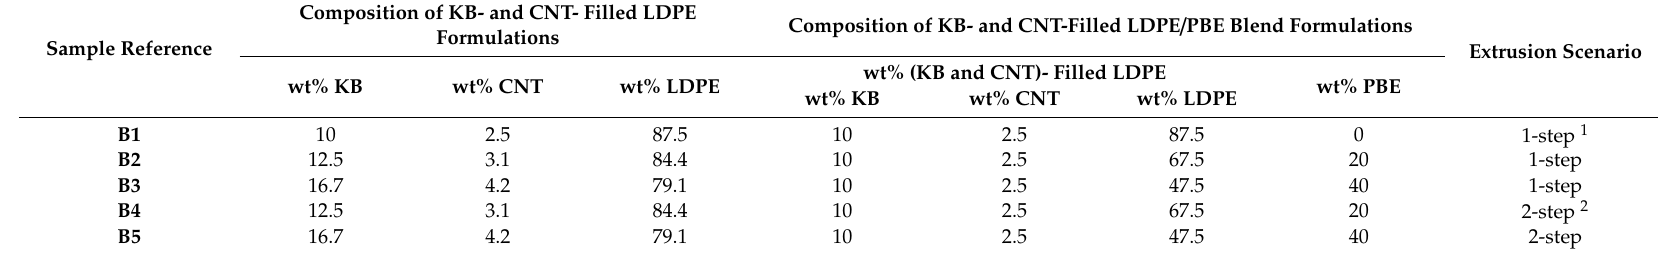
Table 2. Sample descriptions of the second design of